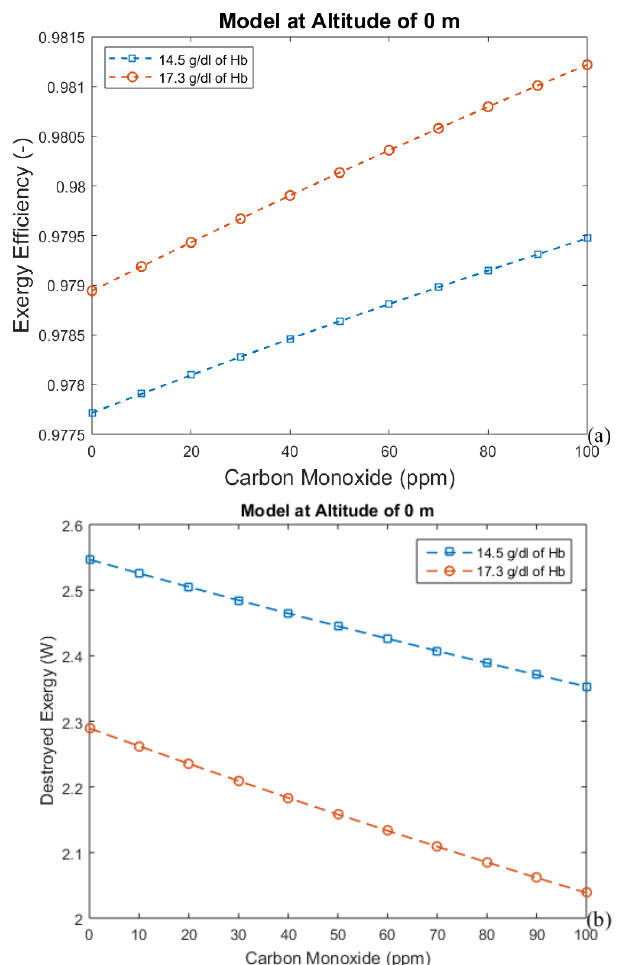
Figure 4. ( a ) Exergy efficiency and ( b ) destroyed exergy as functions of carbon monoxide and hemoglobin (Hb) concentration at sea level.